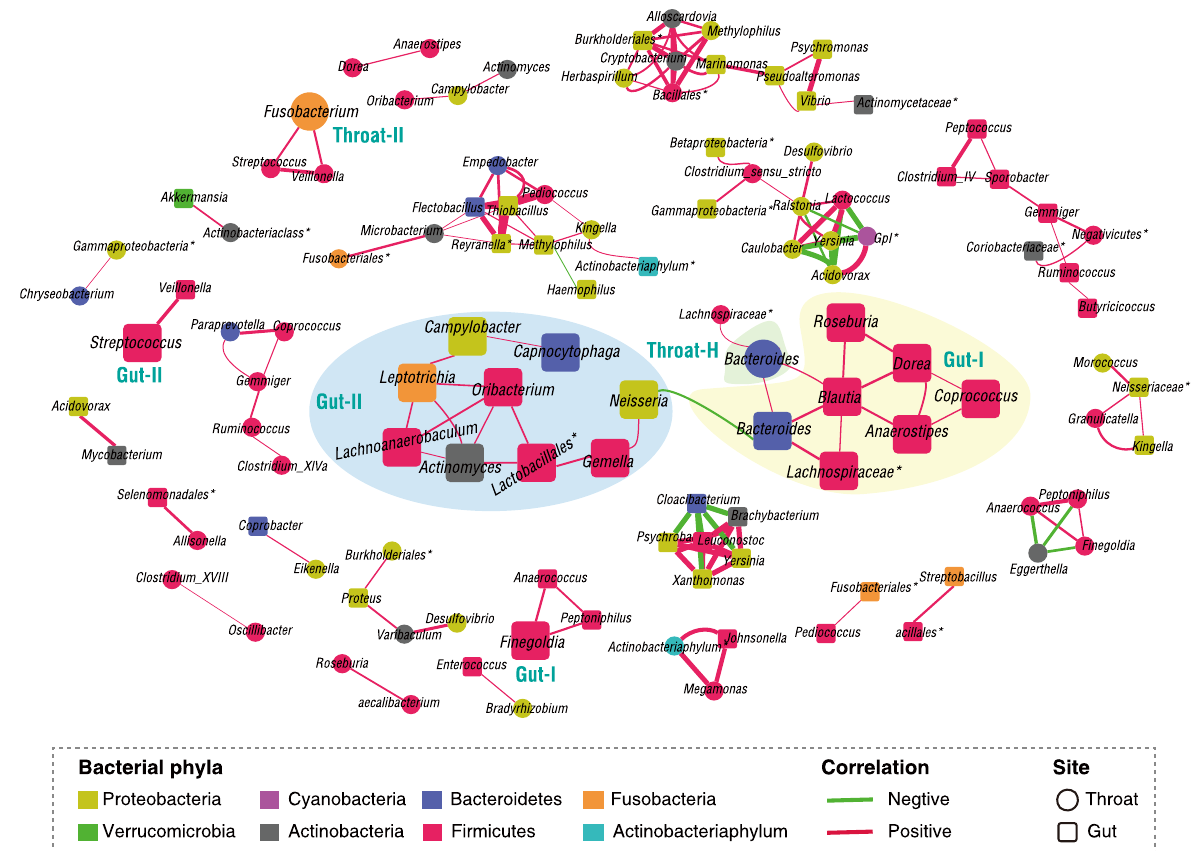
Fig. 5 Co-occurrence networks of gut and throat microbiota within 13 COVID-19 patients. Pearson correlation was employed to calculate correlation coef fi cient (r) between bacterial genus pairs based on their relative abundances. Co-occurred pairs with r > 0.7 under FDR-adjusted P < 0.05 were shown and visualized by Cytoscape version 3.8.0. Edges were sized based on r values. The bigger squares or circles were indicators in Figs. 1d and